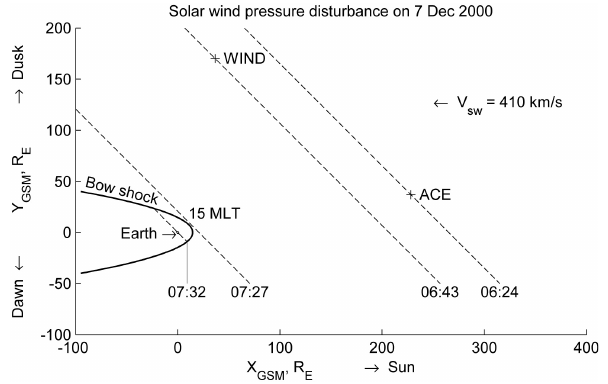
Fig. 1. Orientation of the solar wind dynamic pressure front (dashed lines) in the X–Y plane as observed by the WIND and ACE space- crafts. The disturbance arrived at the bow shock near the 15 MLT